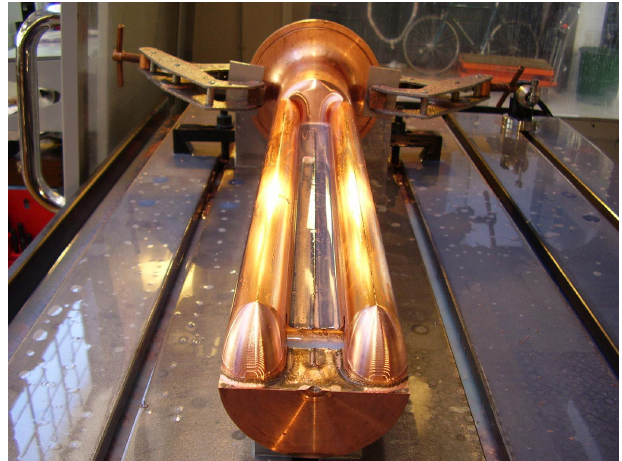
FIG. 1. (Color) The prototype 2-QWR halfway through the CNC machining